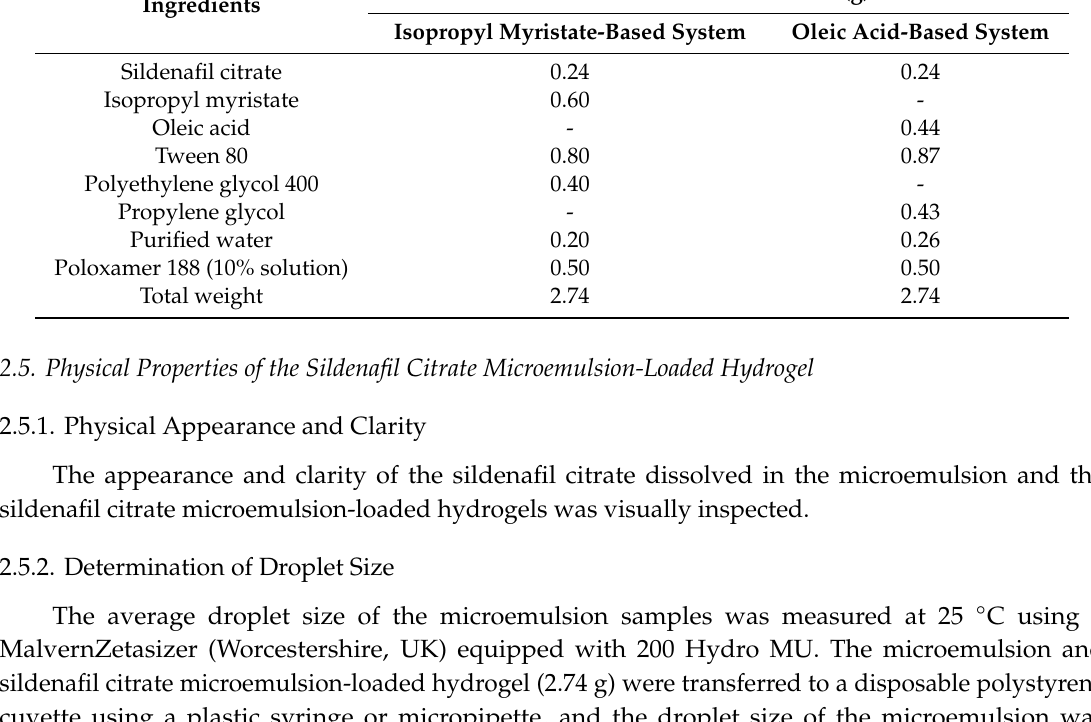
Table 1. Composition of the sildenafil citrate microemulsion-loaded hydrogel formulations. Formulations and Amount (g) Ingredients Isopropyl Myristate-Based